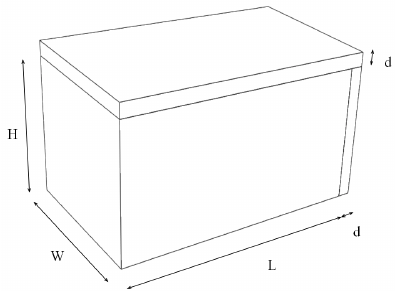
Figure 1. Schematic diagram of basic unit of block wall.